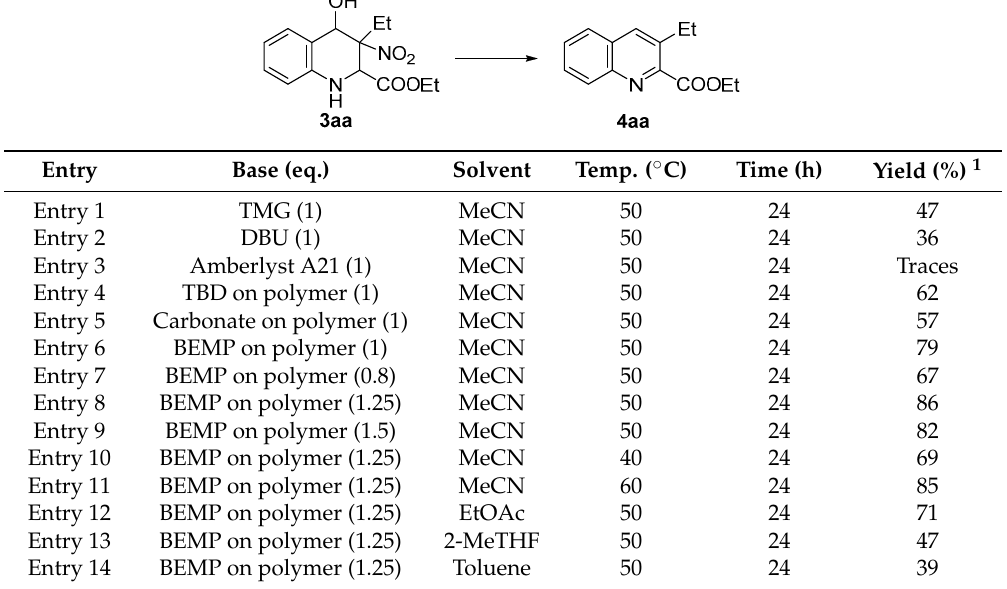
Table 2. Optimization studies concerning aromatization step.